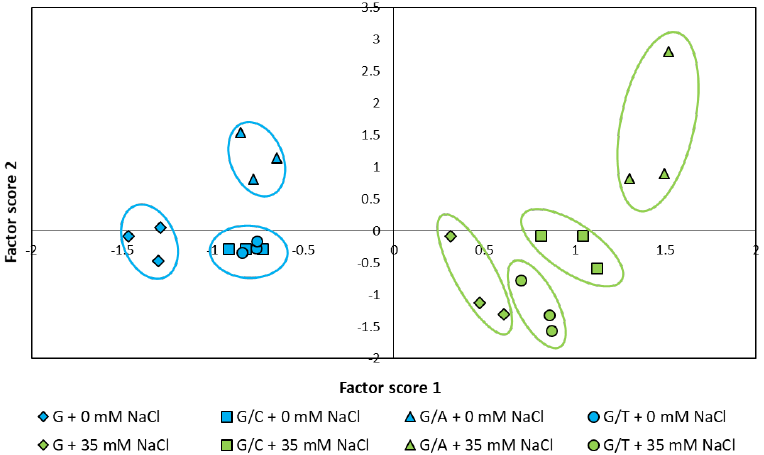
Figure 7. Bi-Plot representing the score values of pepper plants of the commercial variety “Gacela F1” either non-grafted (G) or grafted onto the commercial rootstocks Creonte (G/C), Atlante (G/A), and Terrano (T/A), and cultivated under control (0 mM NaCl) and salinity (35 mM NaCl) condi-